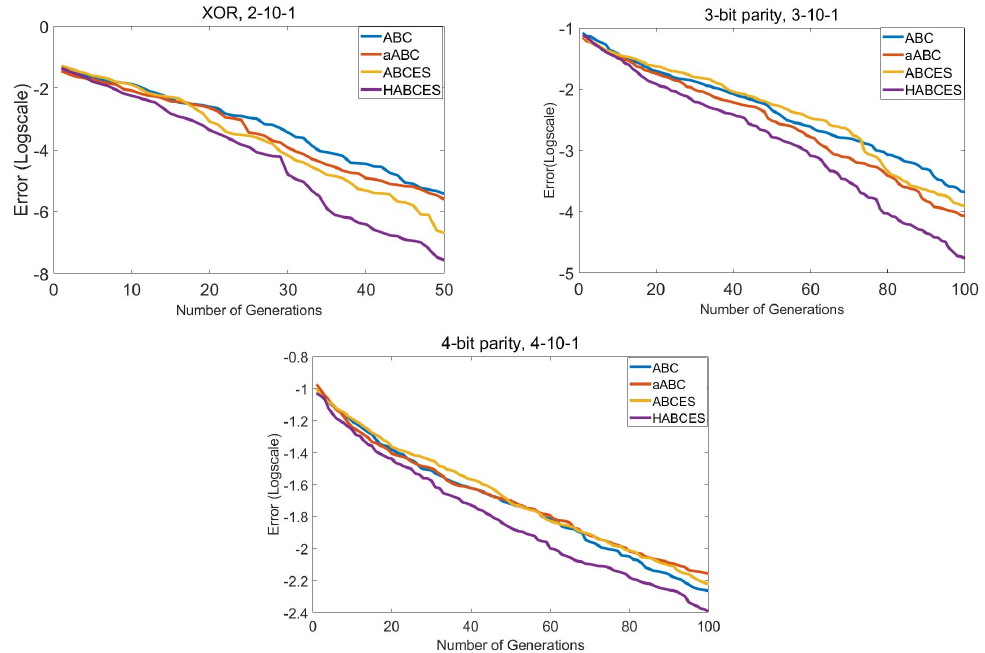
Figure 5. Comparison of the convergences of the ABC, aABC, ABCES and HABCES algorithms when solving parity problems.